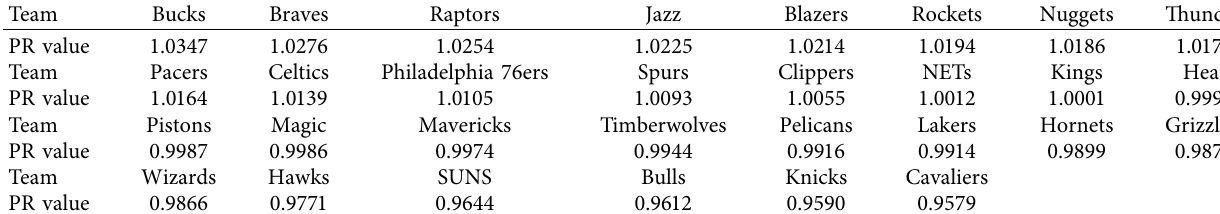
Table 1: Improvement PR index of NBA teams.